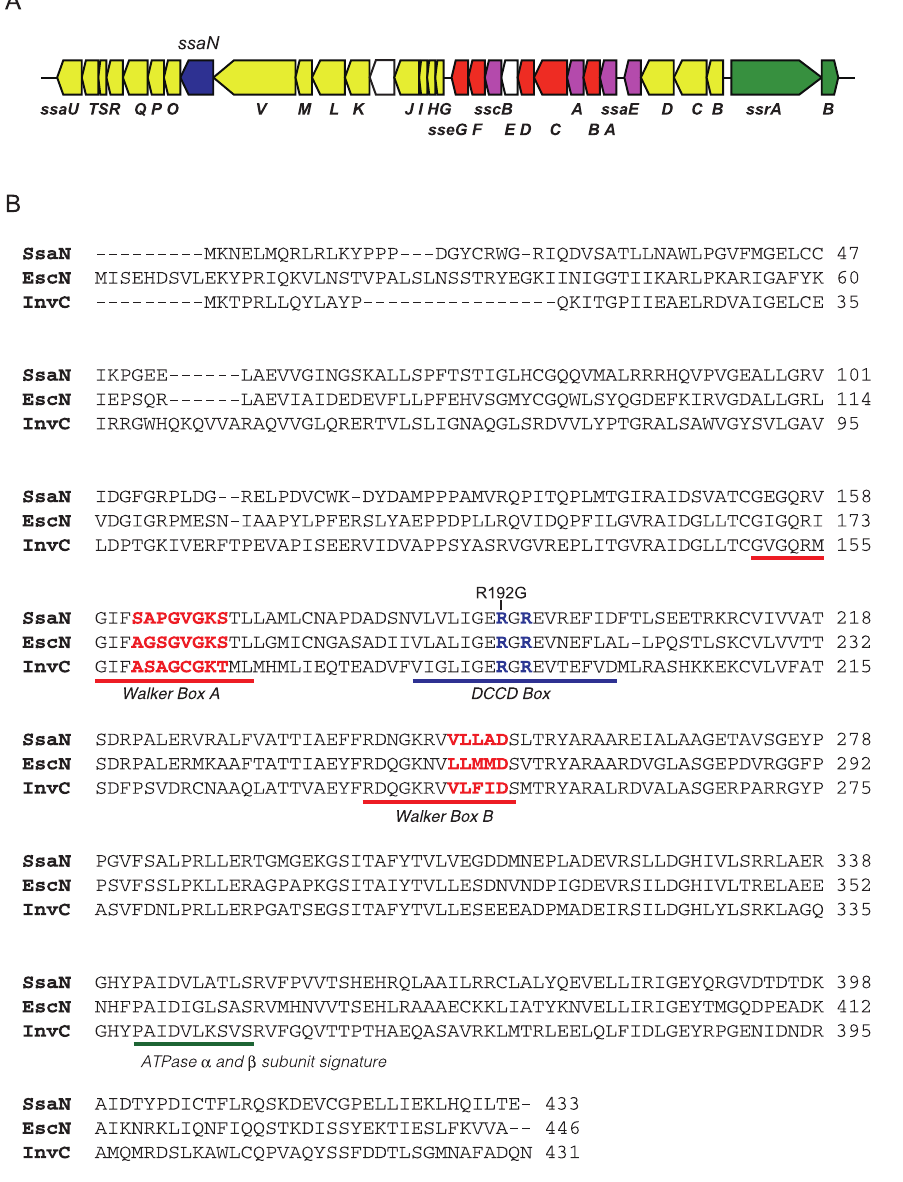
Figure 1. ssaN encodes for a protein with the conserved sequence of other T3SS ATPases. ( A ) Genetic organization of the T3SS-2 genes involved in S . Typhimurium virulence. Genes encoding for proteins for apparatus ( yellow ), effectors and translocators ( red ), chaperones ( purple ), and regulators ( green ) are shown. The ssaN gene is indicated by blue . The genes ssaDCB and ssrA are also referred to as spiBAC and spiR , respectively. ( B ) Amino acid sequence comparisons of SsaN with the EPEC T3SS ATPase EscN and Salmonella T3SS-1 ATPase InvC. The locations of known predicted motifs within the amino acid sequence of SsaN, including Walker Boxes A and B, the dicyclohexylcarbodiimide-binding site (DCCD) box, and the ATPase a and b subunit signature sites, are indicated. doi:10.1371/journal.pone.0094347.g001 Table 3. Nomenclature of flagellar and pathogenic T3SS components.